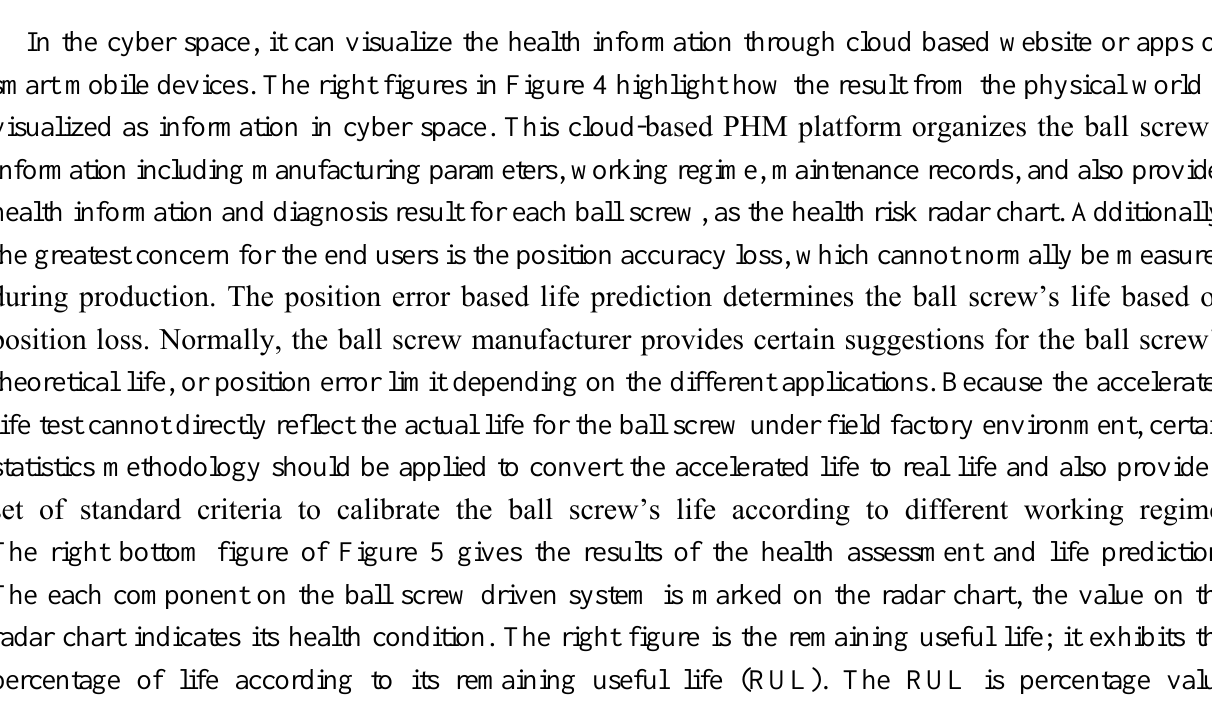
Figure 5. Data to Information